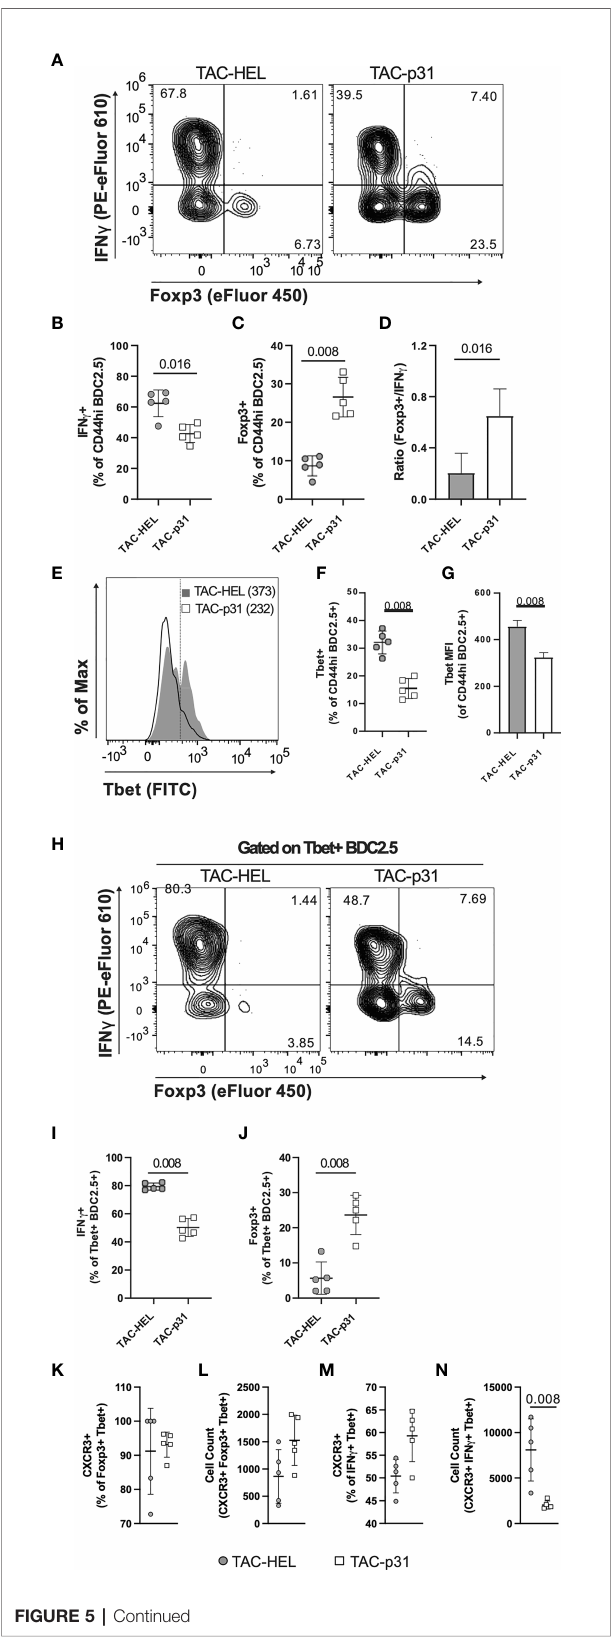
FIGURE 5 | TAC- p31 alters the ratio of BDC2.5 Tregs to Teffs and reduces CXCR3 + Teffs. (A-N) Mice were dosed as described in Figure 3D and phenotype of splenocytes stimulated with p31 was assayed 8 days post- transfer. (A) Representative and quantitative fl ow cytometry of frequency (B) IFN g + and (C) Foxp3 + among CD44 hi BDC2.5 cells (CD90.2 + CD4 + BDC2.5 Tetramer + CD44 hi ). (D) Ratio of number of Foxp3 + /number of IFN g + CD44 hi BDC2.5 cells. (E) Representative and quantitative fl ow cytometry of Tbet (F) frequency and (G) expression (median fl uorescence intensity, MFI) among CD44 hi BDC2.5 cells. (H) Representative and quantitative fl ow cytometry of (I) IFN g + and (J) Foxp3 + frequency among Tbet + CD44 hi BDC2.5 cells. (K) Frequency and (L) absolute counts of CXCR3 expressing Foxp3 + Tbet + CD44 hi BDC2.5 Treg. (M) Frequency and (N) absolute counts of CXCR3 expressing IFN g + Tbet + CD44 hi BDC2.5 Teff. (A-N) TAC dose was 1x10 9 and peptide squeeze concentration was 200 m M. Each group is fi ve pools of two animal each. Mean +/- SD. Mann-Whitney U Test. Representative of two